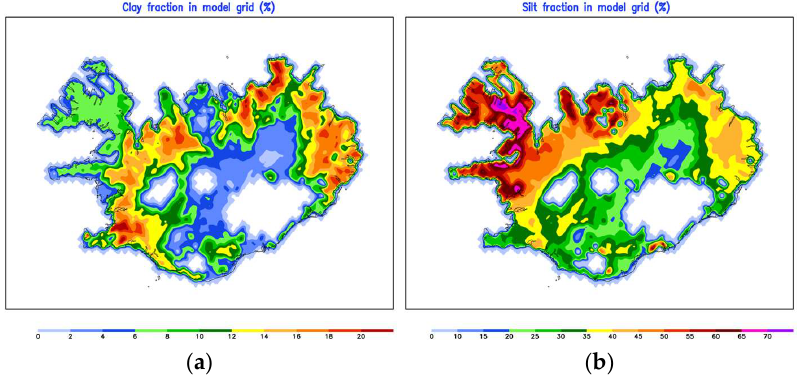
Figure 3. Geographic distribution of clay and silt fractions mapped to the model grid with the resolution of 0.05 degree; ( a ) clay fraction; and ( b ) silt fraction.